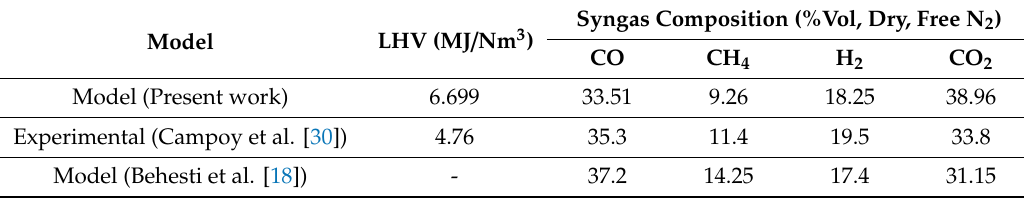
Table 4. Lower heating value (LHV) and composition of the